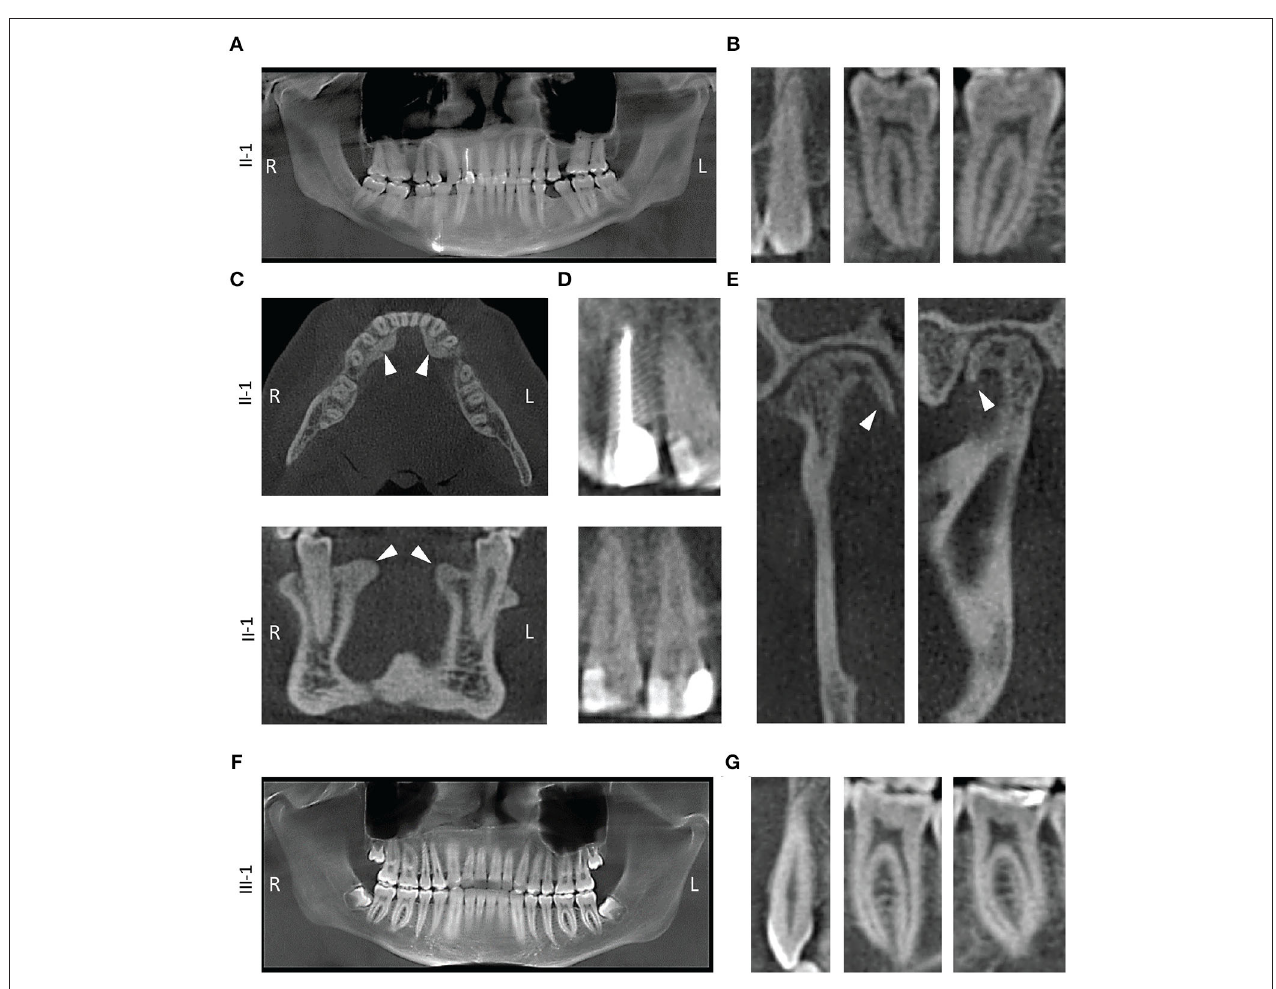
FIGURE 3 | Radiographic findings. (A) Panoramic x-ray from proband II-1 showing thickened dentin and obstructed pulp chambers. (B) 2D slices from II-1 cone beam computed tomography (CBCT) exam showing tooth # 11, 21, and 30 with constricted pulp canals. (C) Transverse (top) and a coronal (bottom) slice of the mandible showing lingual tori (white arrowheads). (D) Restorations in the teeth of proband with a root canal on tooth #7 (top) and class V restorations with teeth # 8 and 9 (bottom). (E) Coronal (left) and a sagittal (right) slice of the right mandibular condyle showing osteophytes (white arrowhead). (F) Panoramic x-ray from III-1. (G) 2D slices showing tooth # 11, 21, and